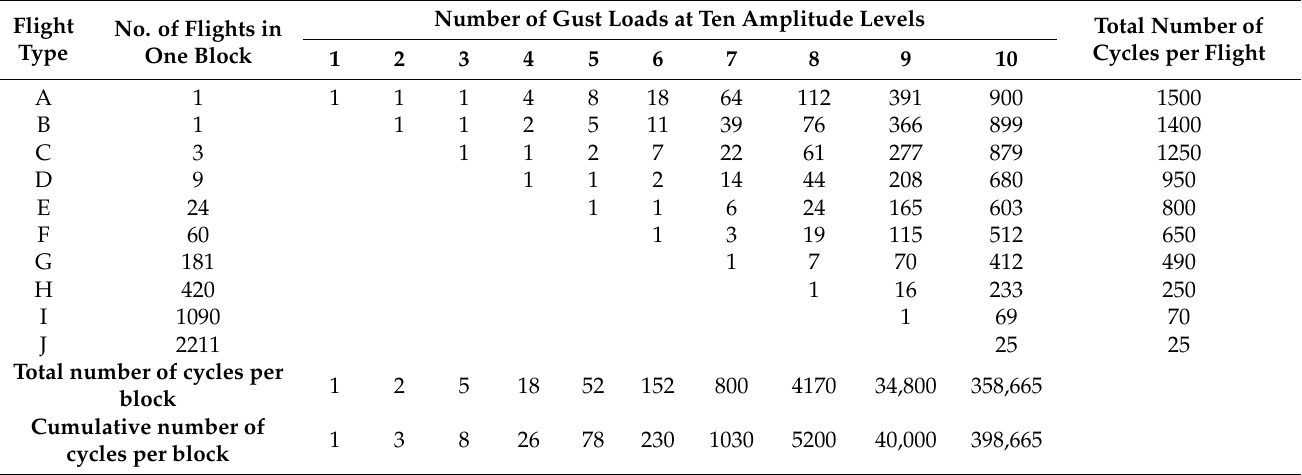
Table 1. Definition of flight types and number of load cycles in each flight type in the TWIST